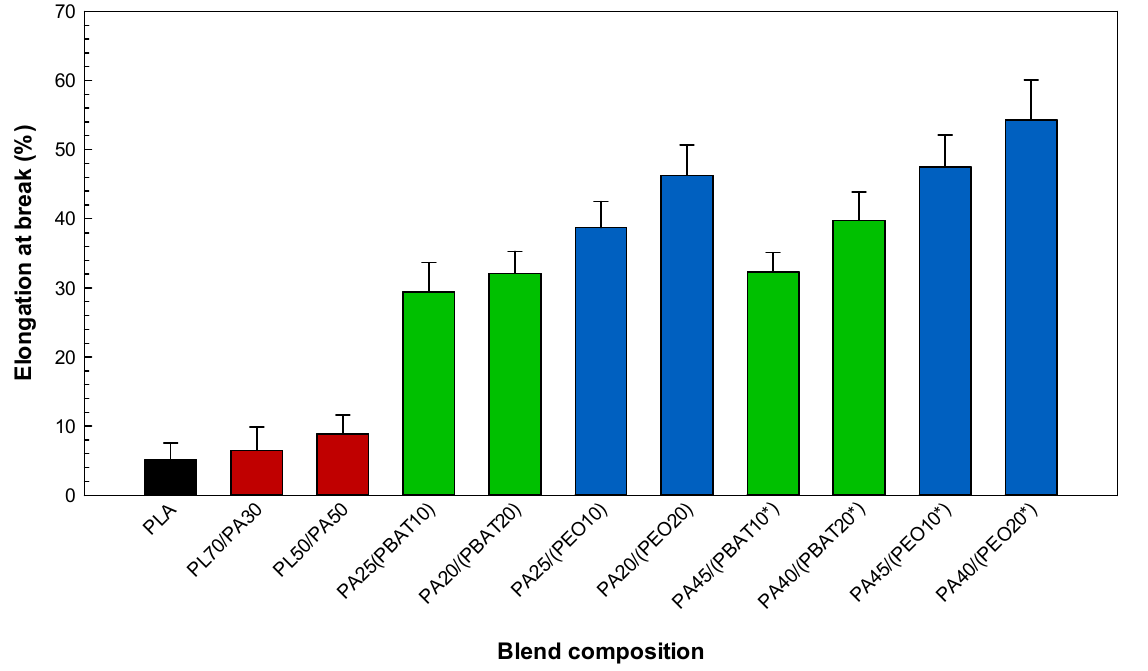
Figure 6. Elongation at break of the blends (see Section 3.2 for definition).